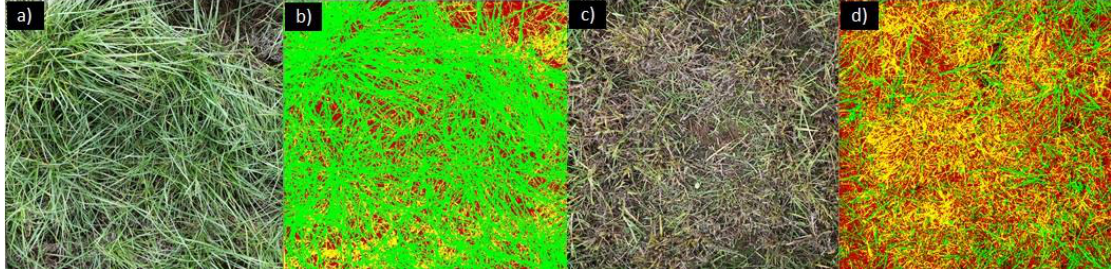
Figure 10. K - nearest neighbor image classification of preharvest ( a ) and postharvest ( c ) images of the same plot (plot no 8); ( b ) and ( d ) are classified images of original images, where green color represents living pasture, yellow color represents senescent pasture, and brown color area is bare ground.